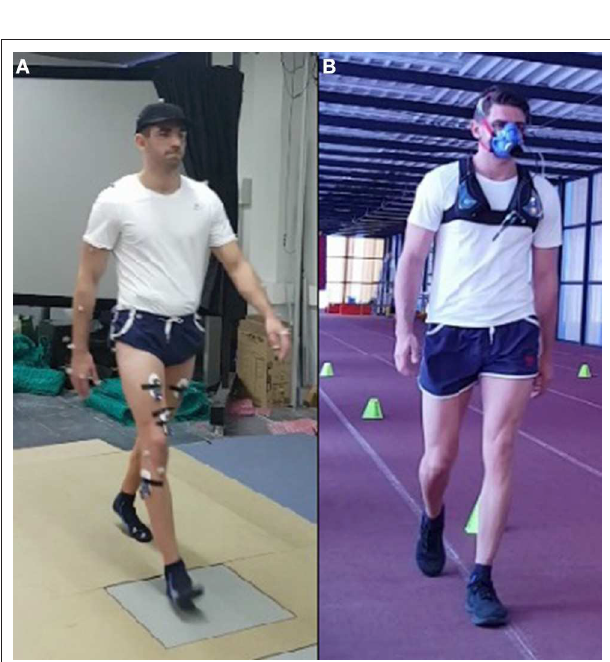
FIGURE 3 | Energy consumption for a healthy subject: (A) motion-force-EMG capture; (B) 5-min test with portable gas analyzer. (Written informed consent was obtained from the individual for the publication of these images. FlM, the main author, is on this picture).